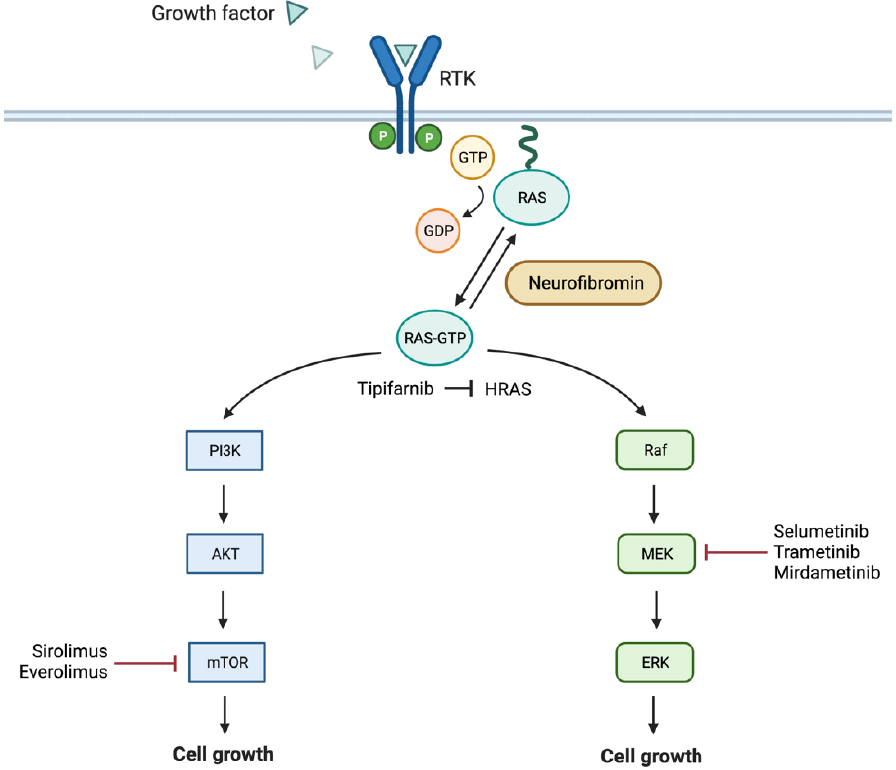
Figure 1. Schematic representation of the main NF1 associated signaling pathways with noted targeted therapies. RTK = receptor tyrosine kinase. Figure created with biorender.com (accessed on 19 October 2021).